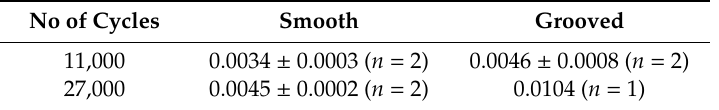
Table 2. Di ff erence of average true strain values of smooth and grooved samples. Table 2. Difference of average true strain values of smooth and grooved samples.